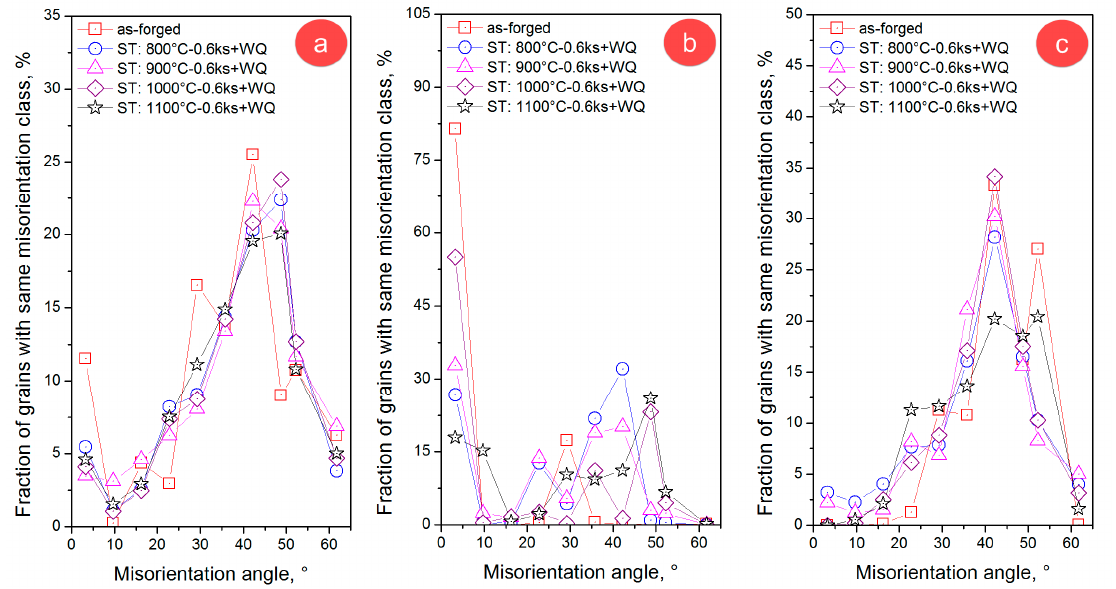
Figure 7. Evolution of fraction of grains with the same misorientation class in the case of: ( a ) γ -Fe/ γ -Fe grains; ( b ) δ -Fe/ δ -Fe grains; ( c ) γ -Fe/ δ -Fe grains.